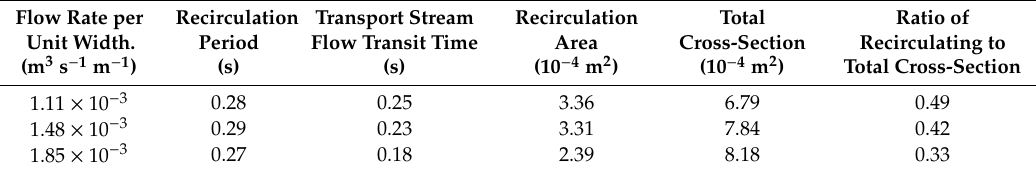
Table 2. Hydraulic features of potential photobiologic significance for validated model at 9 ◦ slope. Flow Rate per Unit Width.